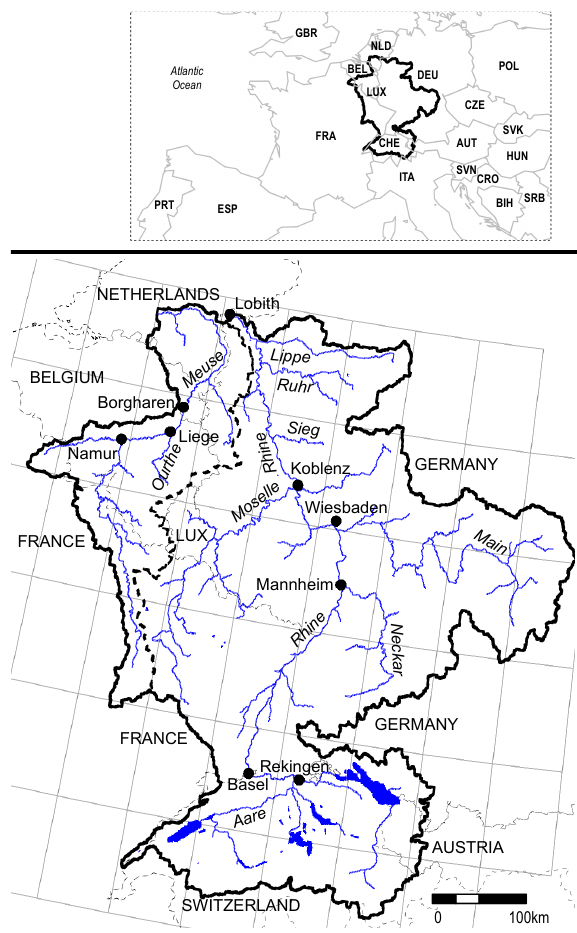
Fig. 1. The combined Rhine-Meuse basin used as the test bed for this model. The bold black line indicates the scope of the model area while the bold dashed line indicates the approximate border between the Meuse and Rhine basins. The major rivers and large lakes are indicated in blue. The map shown in the upper part indi- cates the location of the study area in